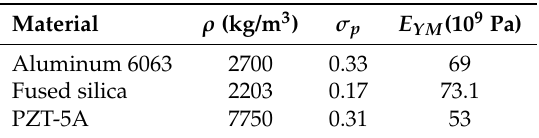
Table 1. Material